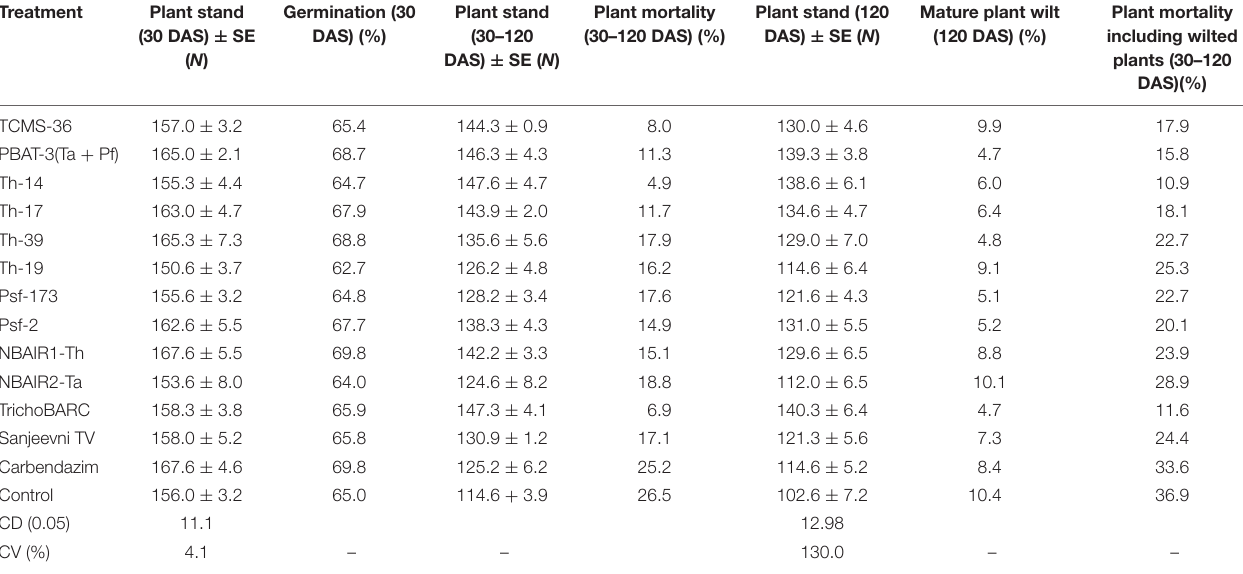
TABLE 1 | Efficacy of bio-agents against seed and plant mortality of chickpea in field at Crop Research Centre, Pantnagar (2017–2018).